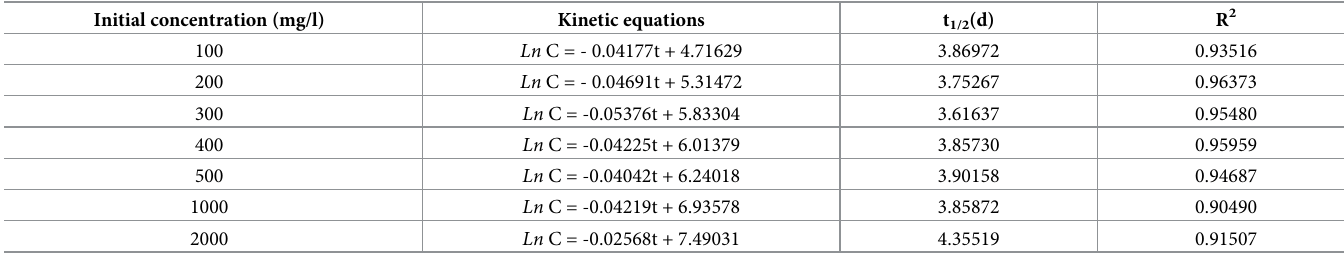
Table 1. Degradation kinetics of DEHP by